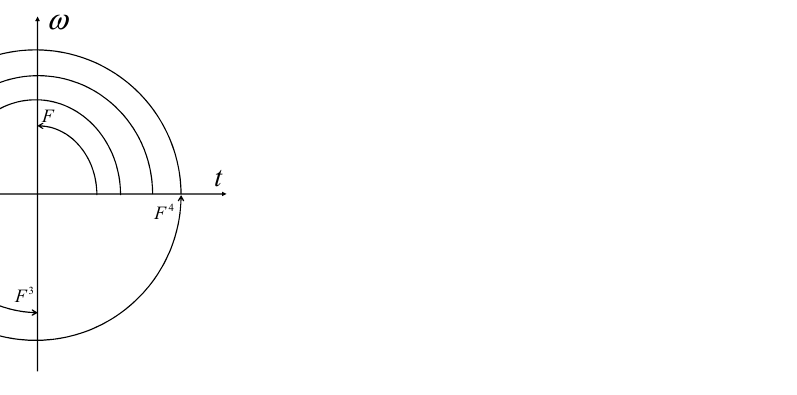
Figure 2. Time–frequency representation of Fourier transform. Obviously, I and 2 DFT are real matrices. In Equation (13), each element of the DFT can be expressed as